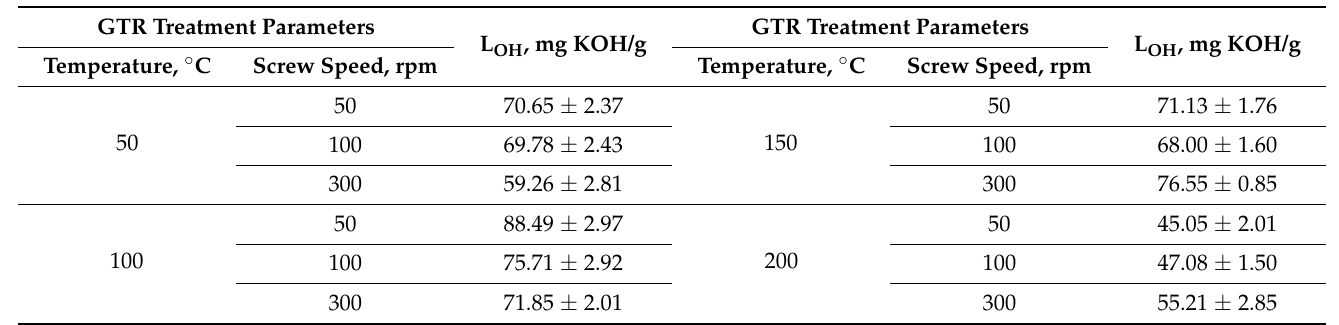
Table 1. Hydroxyl values of thermomechanically modified GTR particles depending on the applied processing conditions.